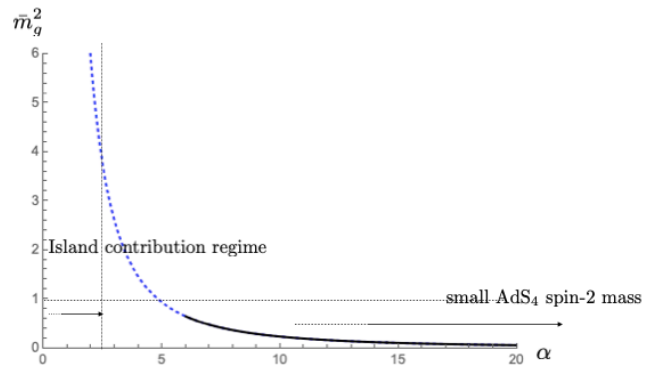
Figure 6 . Zero temperature configuration: it can be observed that parametrically small masses ( ¯ m 2 (cid:28) 1) are achieved in the regime of α (cid:29) 5 . 0 . Only the black part of the curve can be computed g using the expression for the